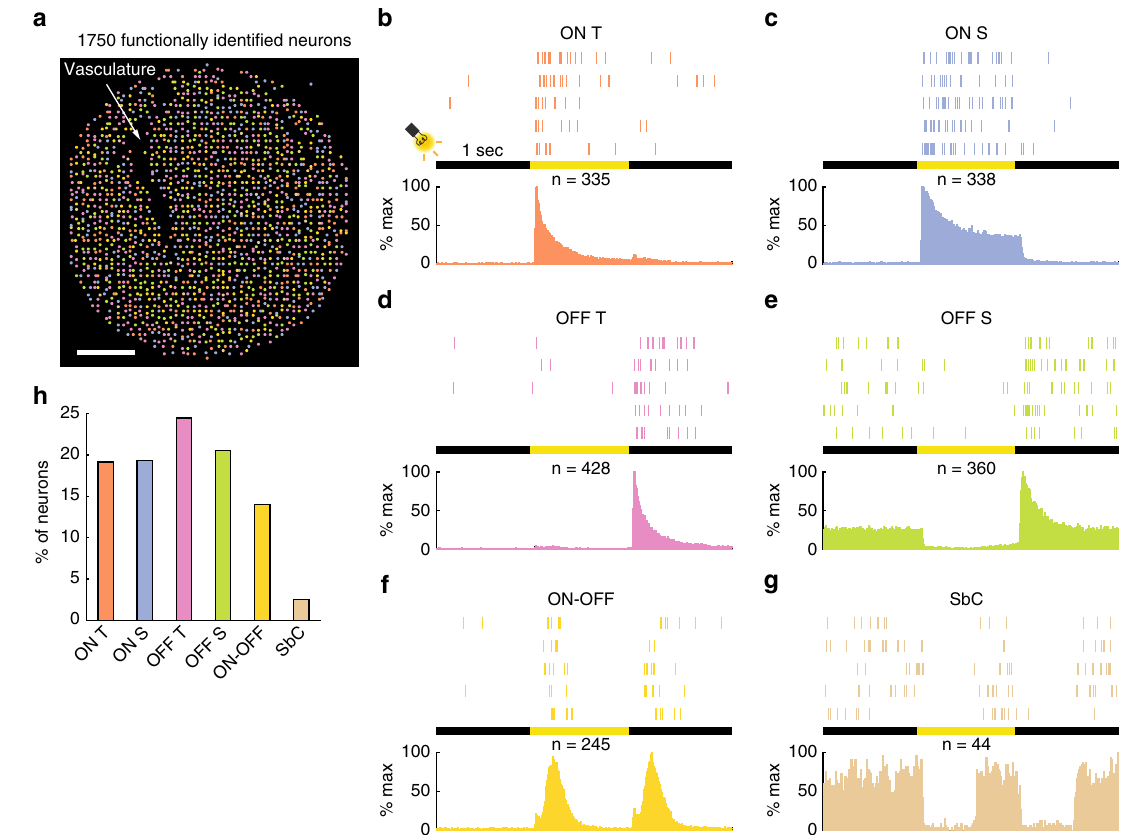
Fig. 4 Functional classi fi cation of neurons using automated processing pipeline. The stimuli were 1-s, 1122- µ m diameter, light spots. a Data from a sensing area of 1377 × 1275 µ m were automatically analysed and, upon satisfying appropriate response characteristics, classi fi ed into one of six functional classes. Scale bar, 225 µ m. b – g Raster plot for a representative ON transient RGC b , ON sustained RGC c , OFF transient RGC d , OFF sustained RGC e , ON – OFF RGC f , and suppression-by-contrast (SbC) RGC g , to fi ve repetitions of one-second light fl ash. The peri-stimulus time histogram (10 ms bins) beneath each raster shows the normalized fi ring rate for all detected neurons in each class. The n-numbers denote the neurons considered in each histogram. All neurons were recorded simultaneously. h Distribution of functional classes for the identi fi ed neurons in